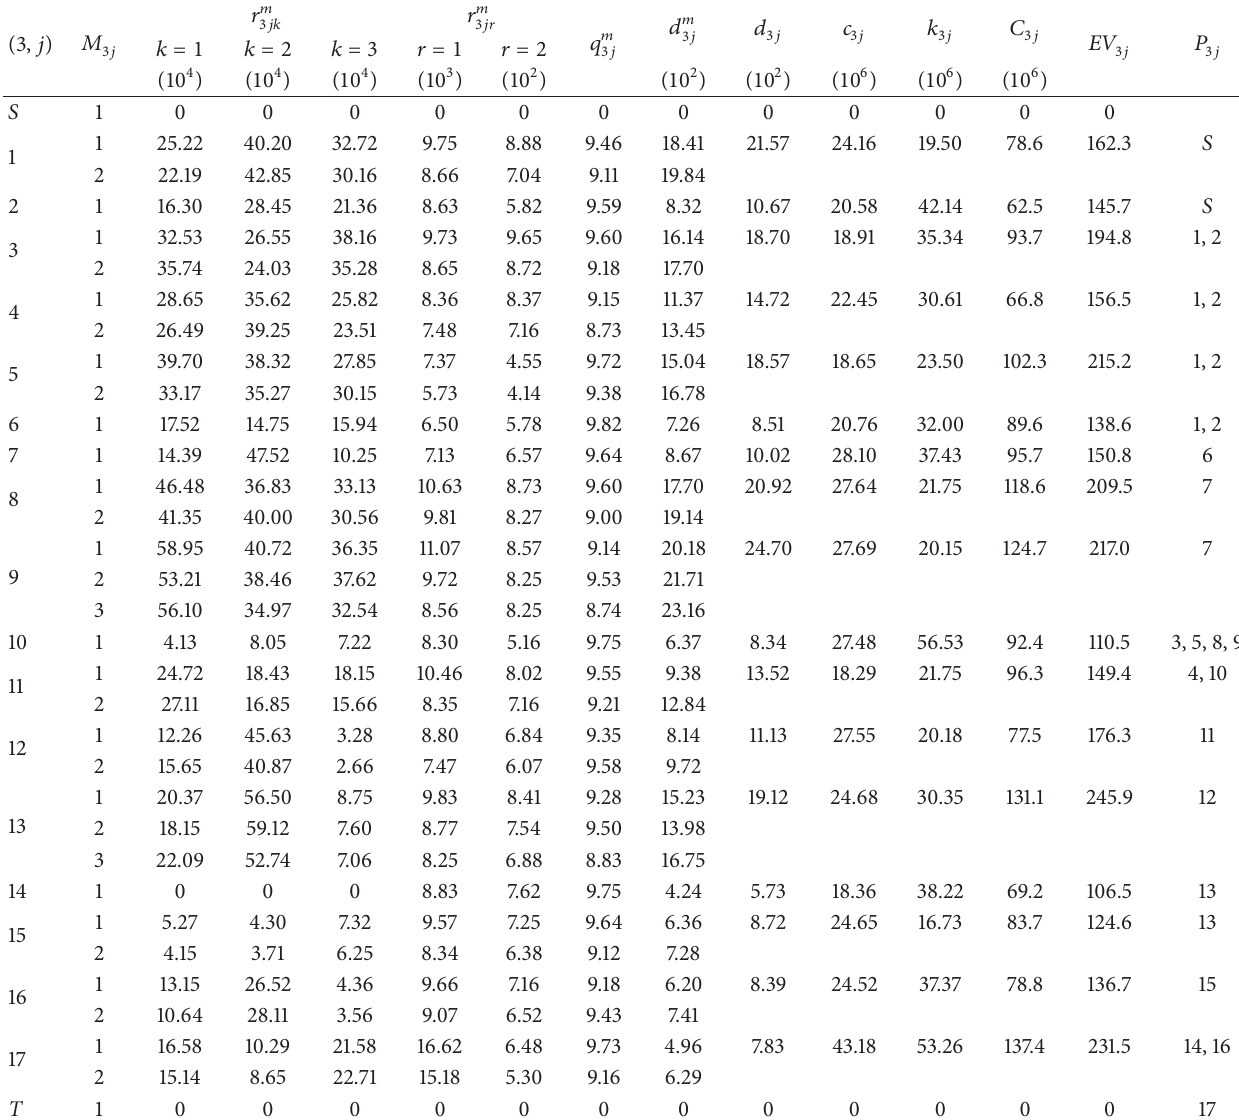
Table 4: Detailed information of each activity in the water power generation system project.